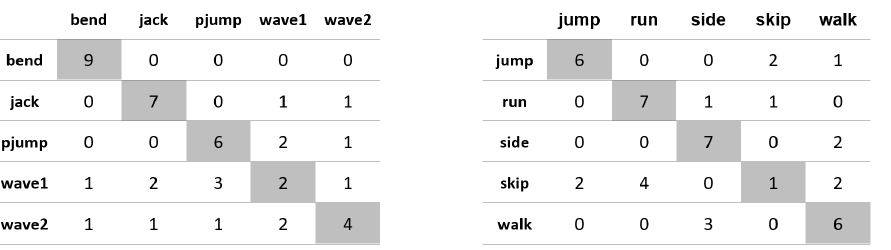
Figure A14. Confusion matrices for the experiment using the ‘lower-occlusion’ database, MBR length and C1